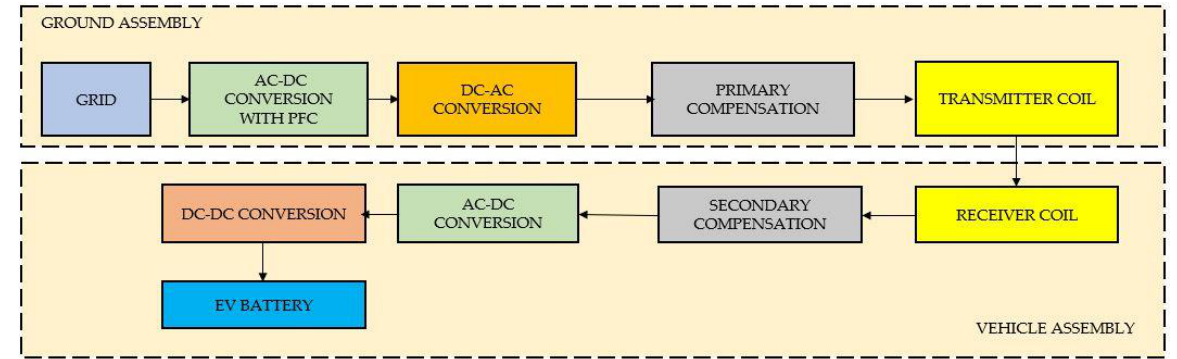
Figure 22. Schematic block diagram of wireless charging.